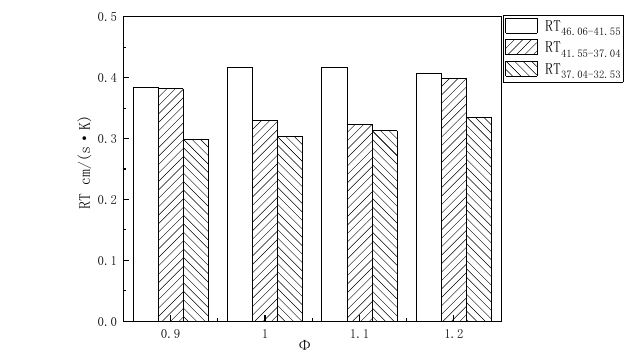
Figure 6. The rate of change R of u L corresponding to Φ. The auxiliary dashed curves in Figure 4 stand for the equivalent effect on the u L of Tu and Pu. The specific equivalent relationship is that the Tu change of ΔT = 25 K and the Pu change of ΔP = 0.05 MPa have equivalent effects on the same variation value of u L . The intersection of the isolines of u L and the auxiliary dashed curves in the figure indicates that Tu and Pu have an equal influence weight on u L at this point. All the equal weight intersection points in the figure are extracted and fitted into curves (refer to Figure 7); three regions are formed by equal weight curves. Among them, region II is the area where Pu has a greater influence on u L , and region I and region III are the areas where Tu has a greater influence on u L . As Φ increases, the equal weight curves of Tu and Pu exhibit different movement patterns. Refer to the figure, as Φ increases and Tu is less than 384 K, the low-pressure equal weight curve (Pu = 0.12–0.15 MPa) gradually moves toward a higher Pu but the increase rate changes more slowly with the increase in Tu. When Tu is greater than 384 K and Φ is 1.1, Pu of the low-pressure equal weight curve reaches the maximum. As such, with the Φ increases, the area of region I below a Tu of 384 K gradually increases, that is, the area in which the initial temperature influence weight is greater gradually increases. In the initial temperature above 384 K of region I, as Φ increases, the area of the region with the greater initial temperature influence weight increases first and then de- creases. Furthermore, as Φ increases and the initial temperature is greater than 412 K, the high-pressure equal weight curve (Pu = 0.19–0.22 MPa) gradually moves toward a higher Pu. When the initial temperature is in the range of 342–412 K and Φ is 1.1, the Pu of the high-pressure equal weight curve reaches the minimum. When the initial temperature is lower than 342 K and Φ is 1.2, the Pu of the high-pressure equal weight curve reaches the minimum. Therefore, as Φ increases, the area in which the initial temperature is larger than 412 K with a greater initial temperature influence weight gradually decreases. While the initial temperature is below 384 K, the area with the greater initial temperature influ- ence weight increases.